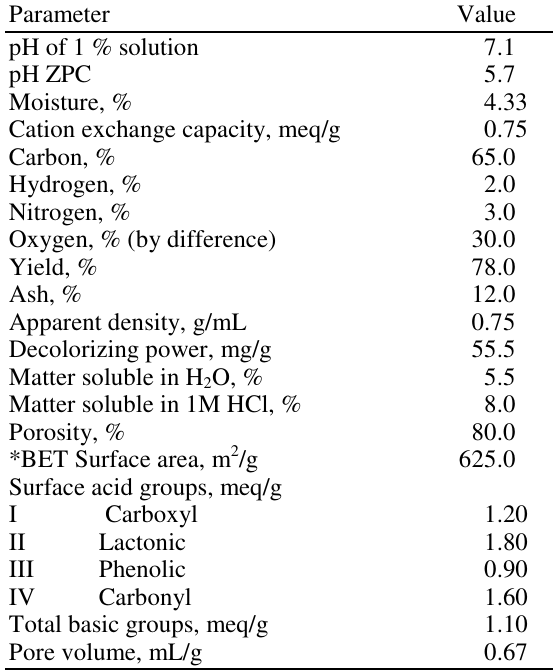
Table 1 . Properties of the activated carbon used for this